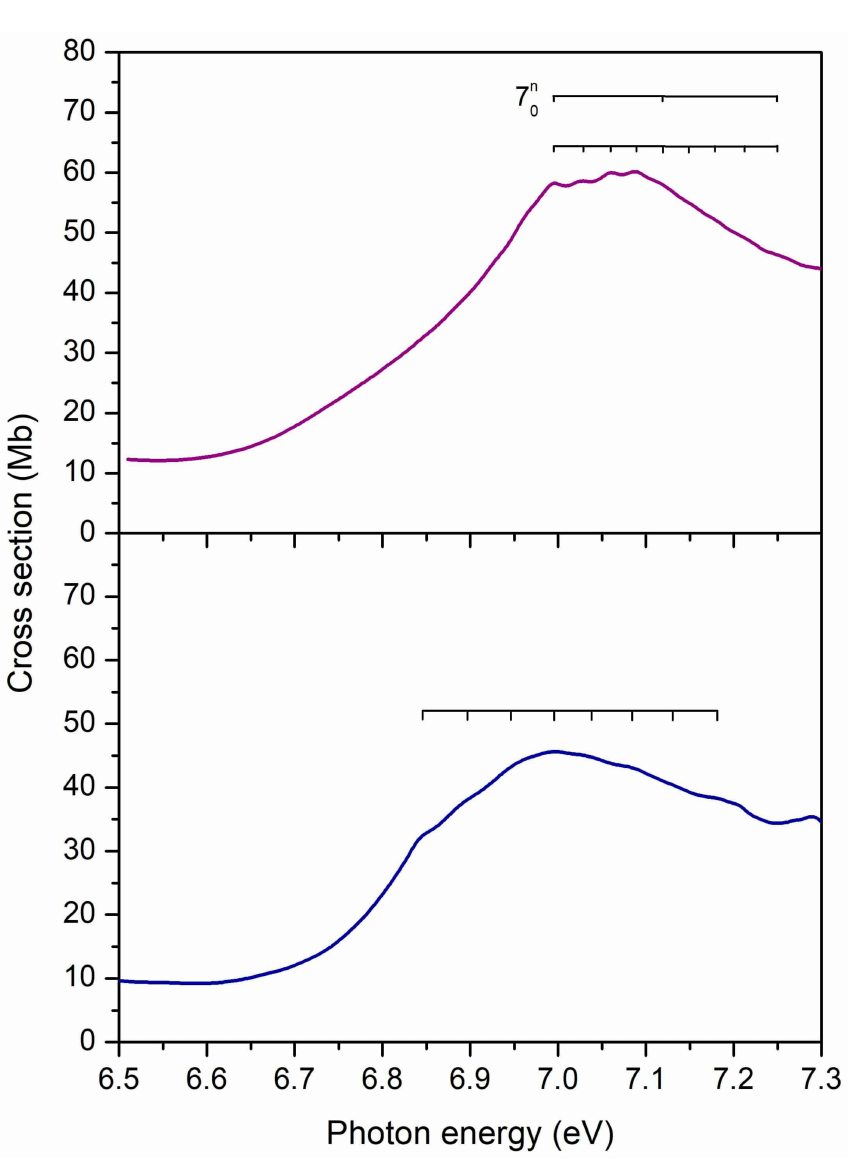
Figure 10. Vibrational progressions in the 6.5–7.3 eV energy range of the absorption Band IV of 2-bromopyrimidine ( top panel) and 5-bromopyrimidine ( bottom